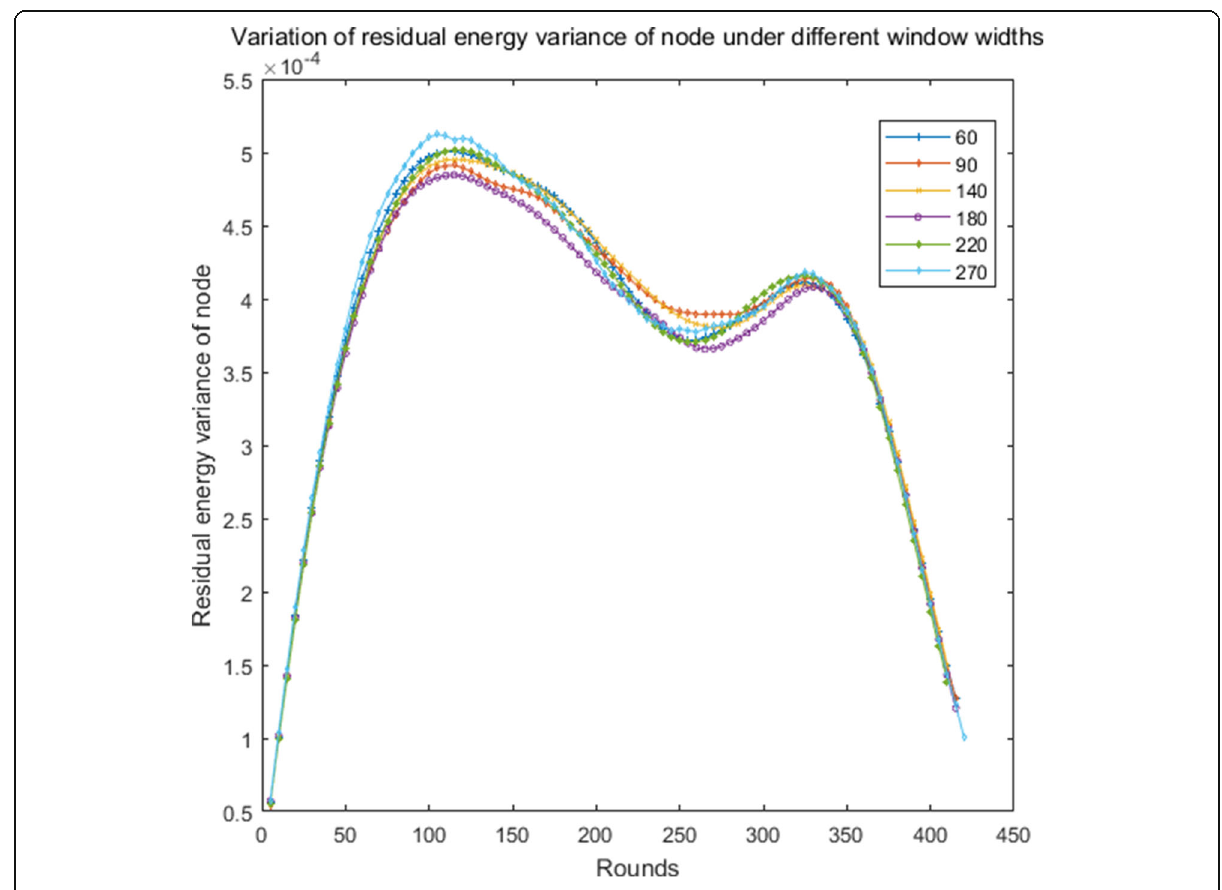
Fig. 18 Residual energy variance of nodes with different window sizes. The change of load balance in different window